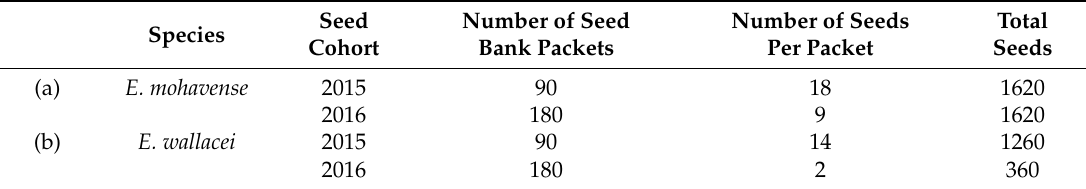
Number of Seeds Per Packet